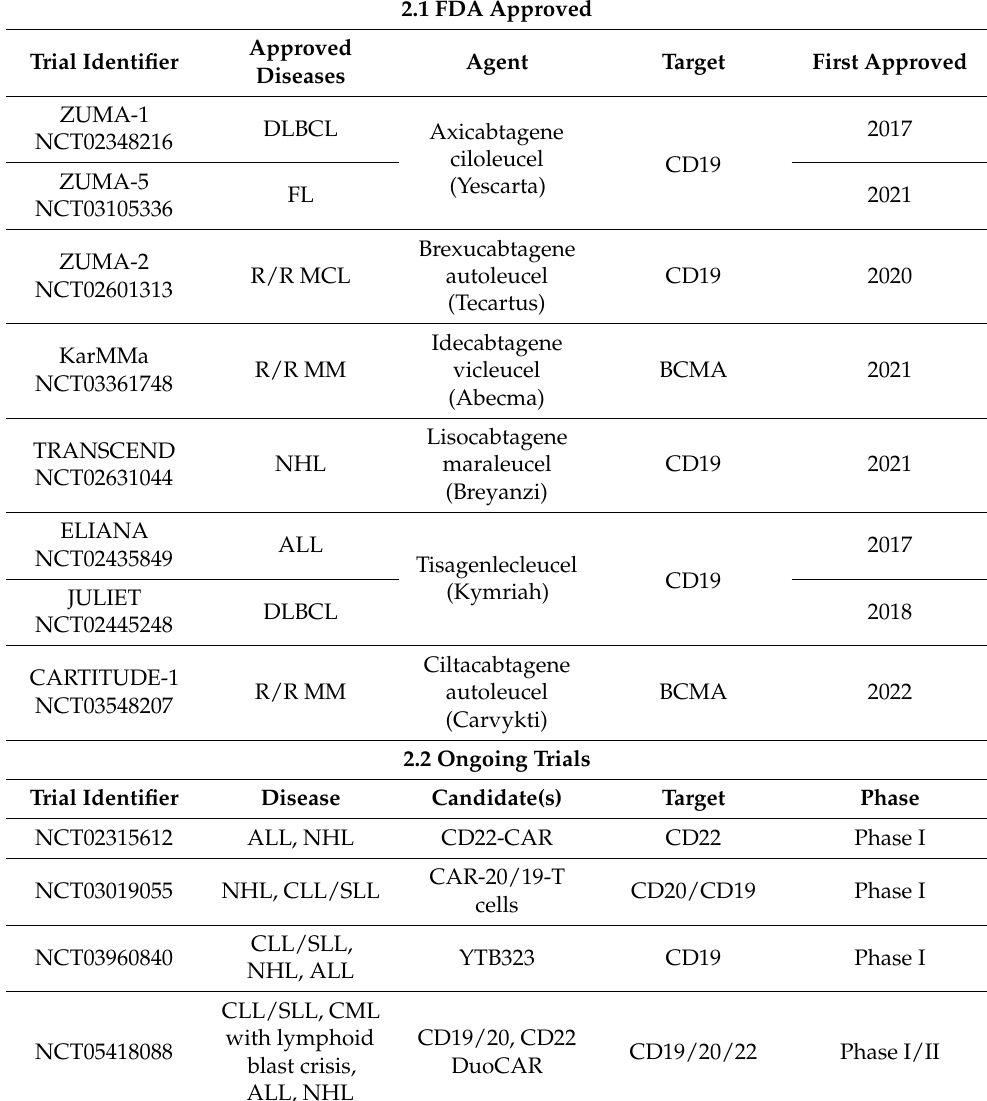
Table 2. FDA-approved and ongoing clinical trials with CAR